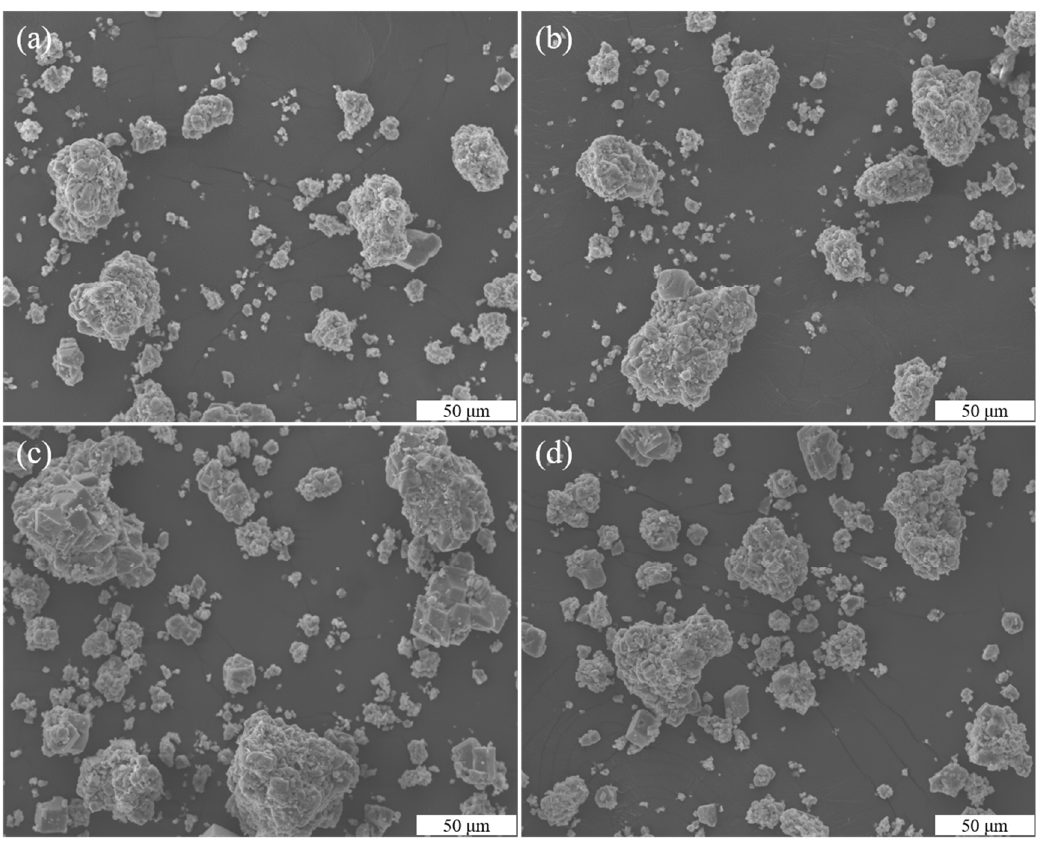
Figure 7. SEM images of CaCO 3 crystals with different quantities of TCS with 0.25% Na-MMT (TCS = 100 ( a ), 200 ( b ), 300 ( c ), and 300 g ( d )).